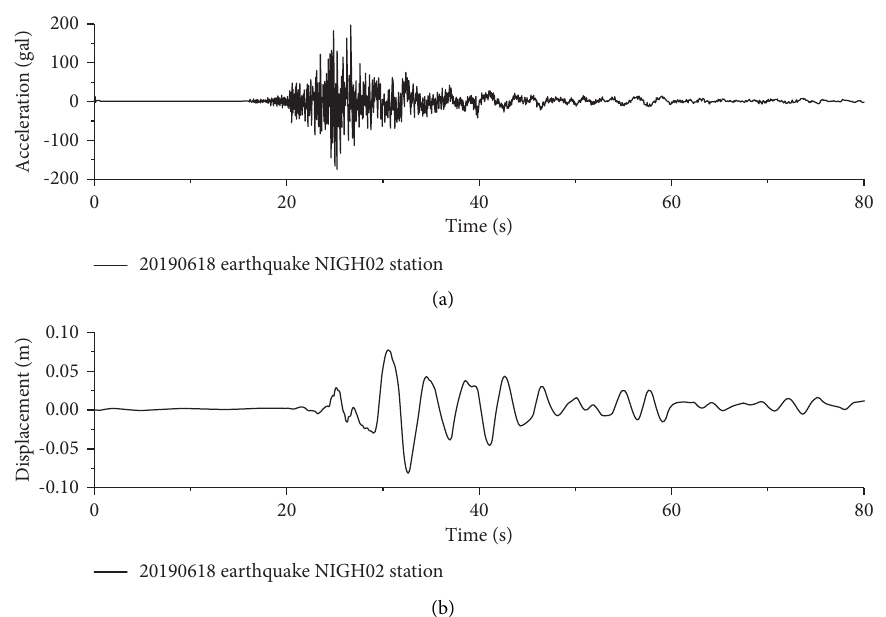
Figure 8: 2019-06-18 Earthquake time history curve at bedrock in the direction of EW-1 at NIGH02 station. (a) Acceleration time history. (b) Displacement time